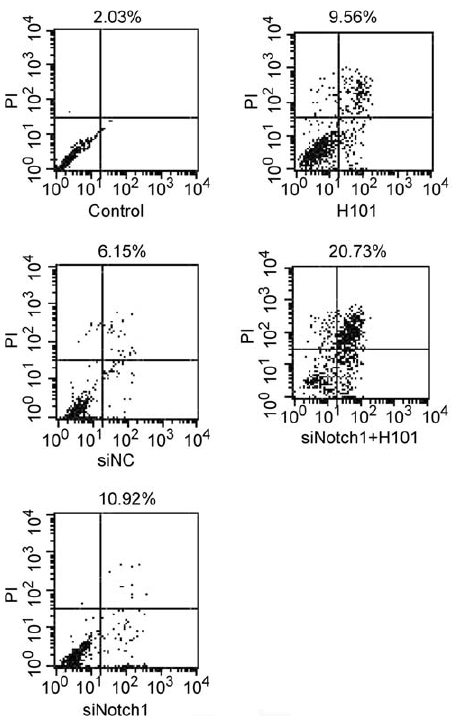
Figure 5. Expression of caspase-3 activation, p53 (A) and MDM2 (B) in HeLa-S3 tumor cells. Cells were transfected with the Notch1-siRNA and H101 for 72 hours, and total protein was analyzed by Western blot with specific antibodies.